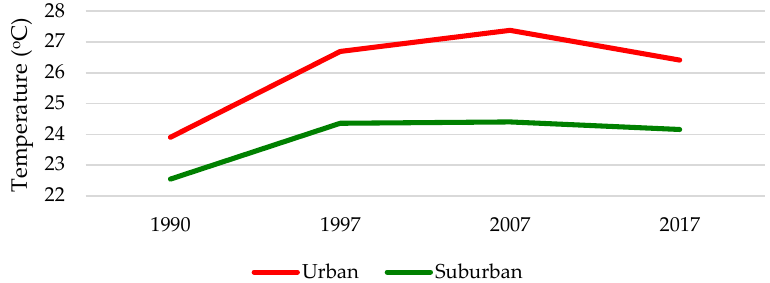
Figure 8. Surface urban heat island (UHI) from 1990 to 2017.